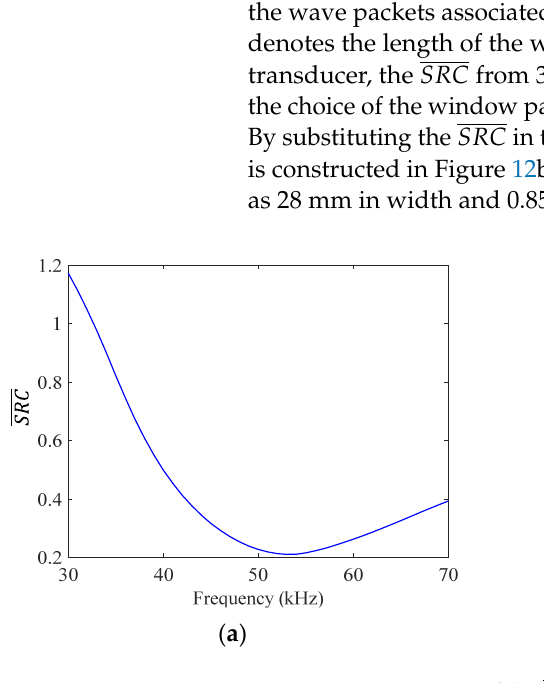
Figure 12. ( a ) Variation of the SRC with respect to frequency; ( b ) damage image for the 30 mm-wide and 1 mm-deep defect.